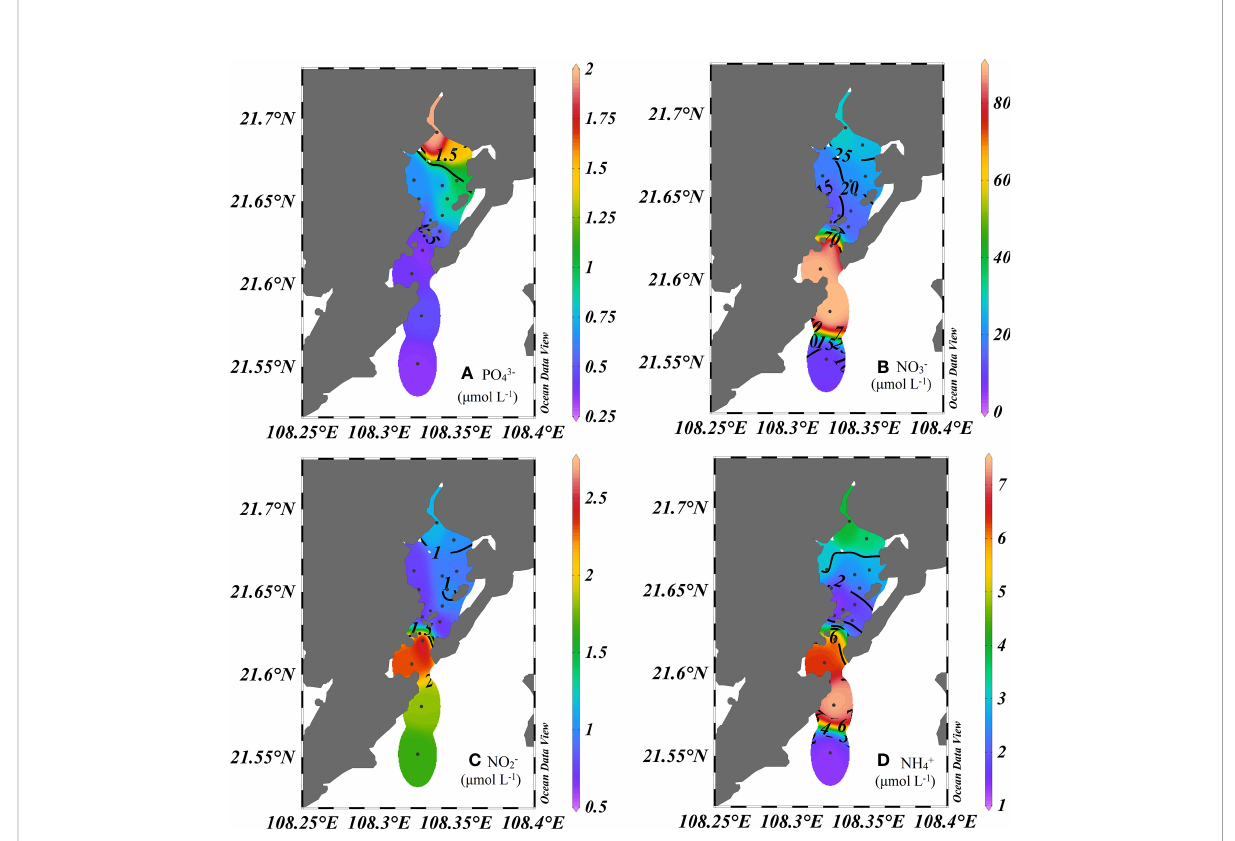
FIGURE 3 Spatial distributions of nutrients in Xi Bay during the rainy season. (A) ,PO 43- (B) , NO 3- (C) , NO 2- (D) , NH 4+